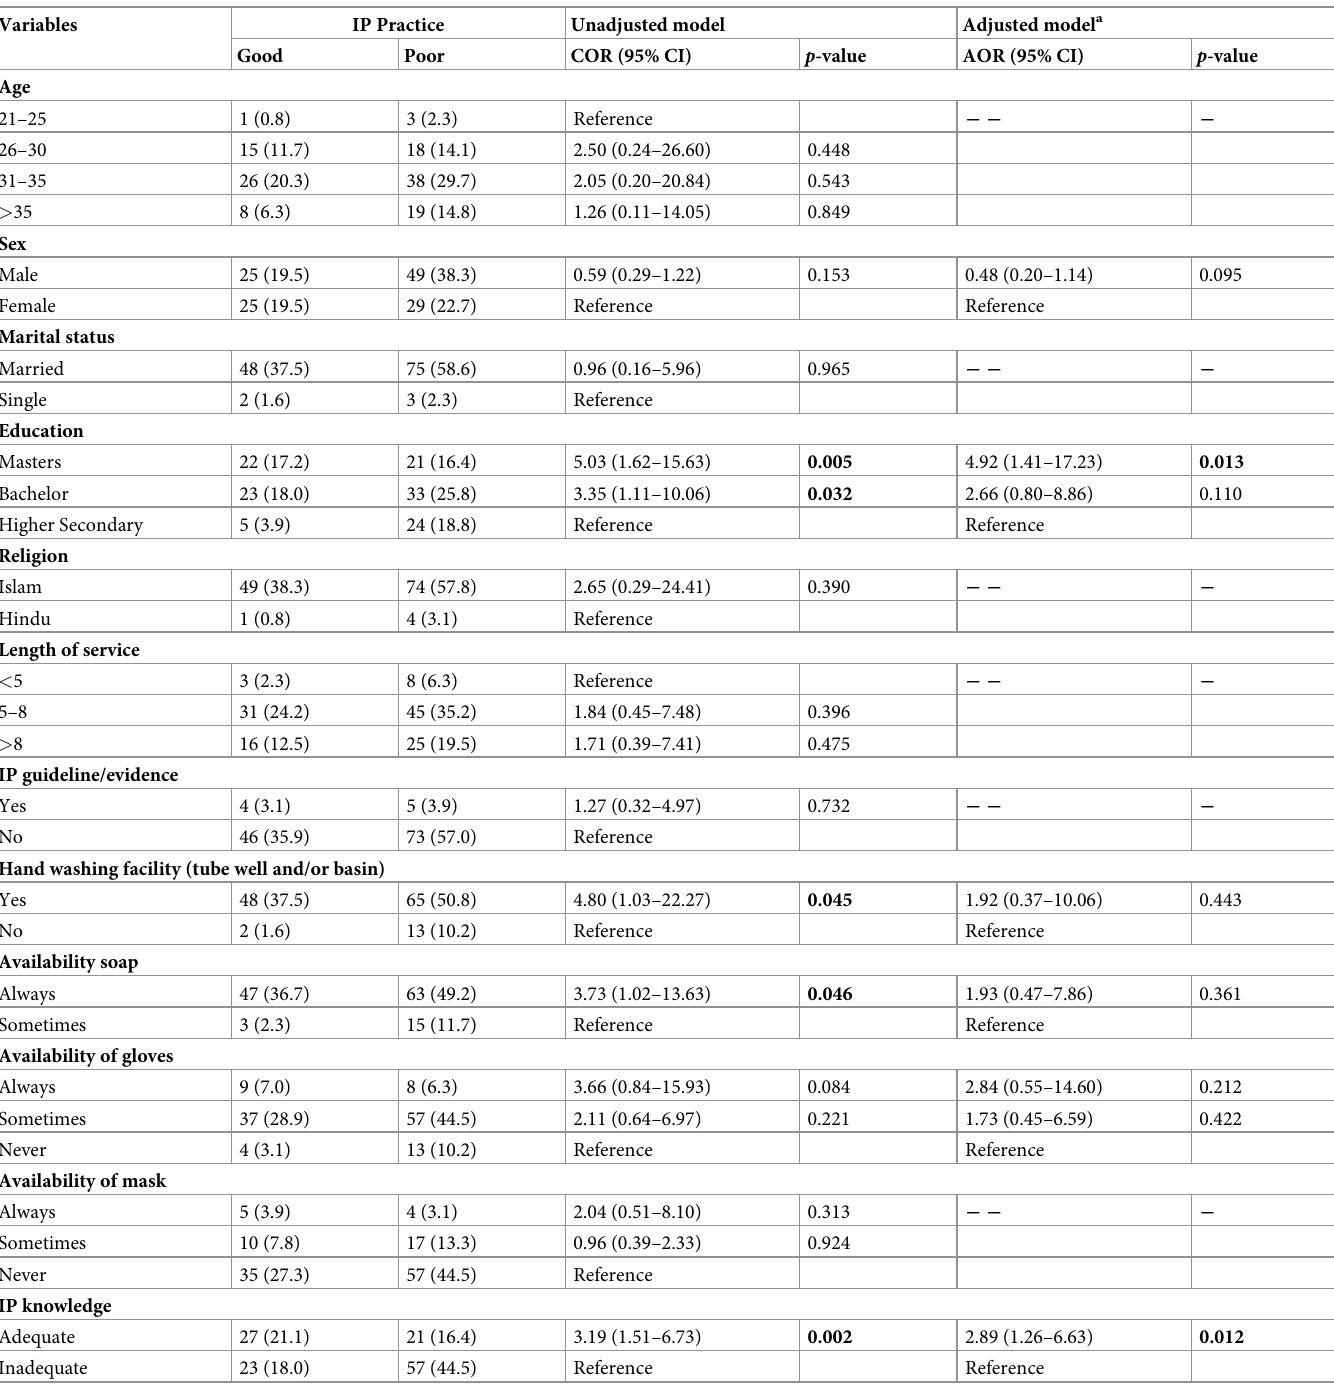
Table 5. Binary and multiple regression analysis of factors associated with infection prevention